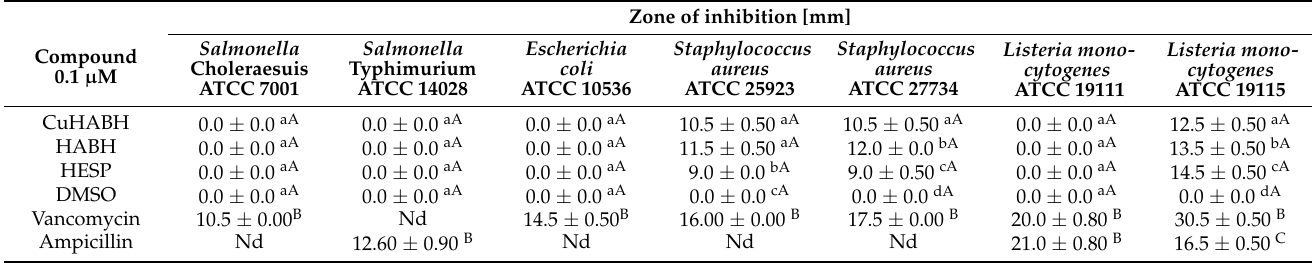
Table 4. Antimicrobial activity of selected compounds against some bacteria strains as diameter zone of